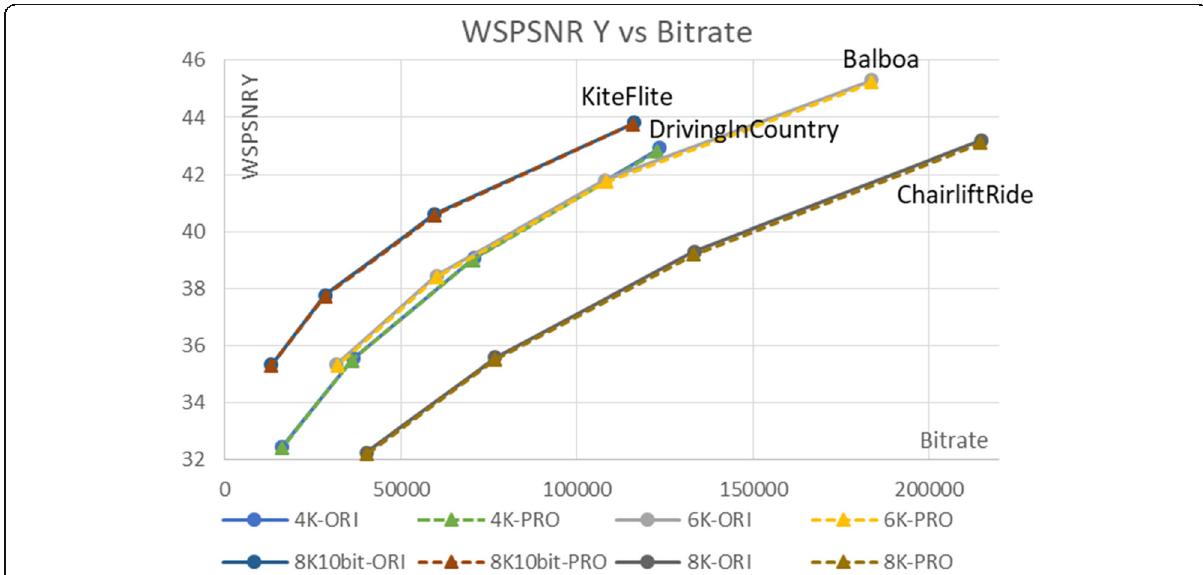
Fig. 14 Comparison of RD curves of different resolution sequences under different QPs (22, 27, 32, 37) between the original HM 16.16 and the proposed overall algorithm